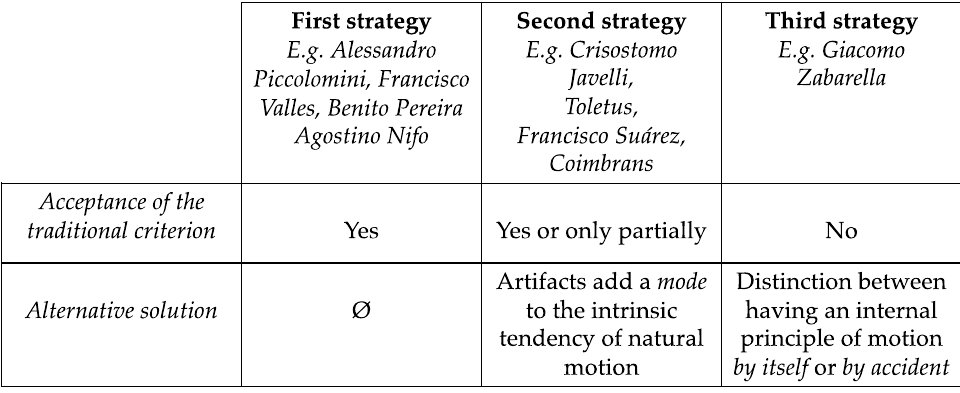
Figure 4. Comparison of the three strategies.